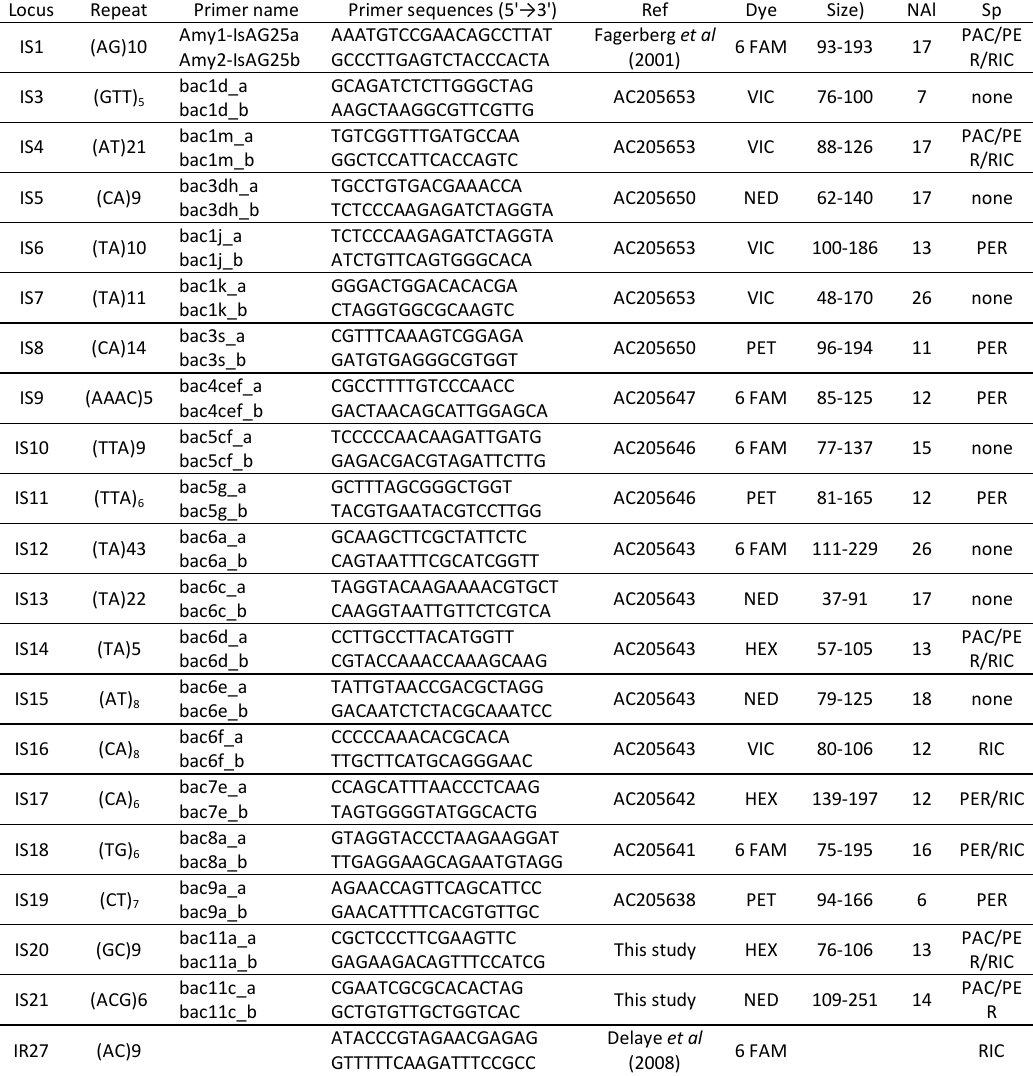
Table 2. List of primer sets used or developed for this study. PAC = Ixodes pacificus , PER = I. persulcatus , RIC = I.